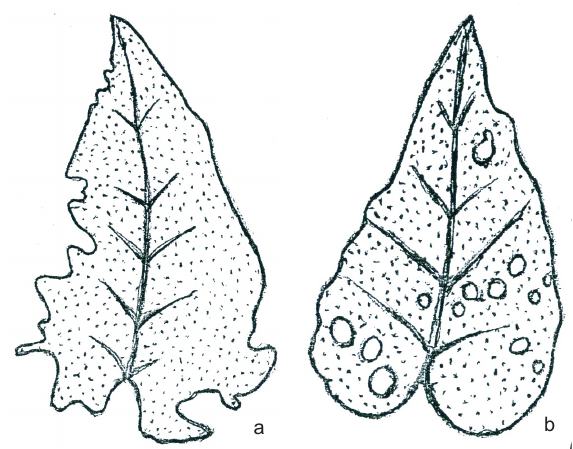
Figure 1. Ipomoea leaves with feeding damage by adults of the tortoise beetle Aspidomorpha . a - Damage by A. sanctae-crucis ; b - Damage by A. miliaris. (Based on photographs in Verma & Shrivastava 1985)